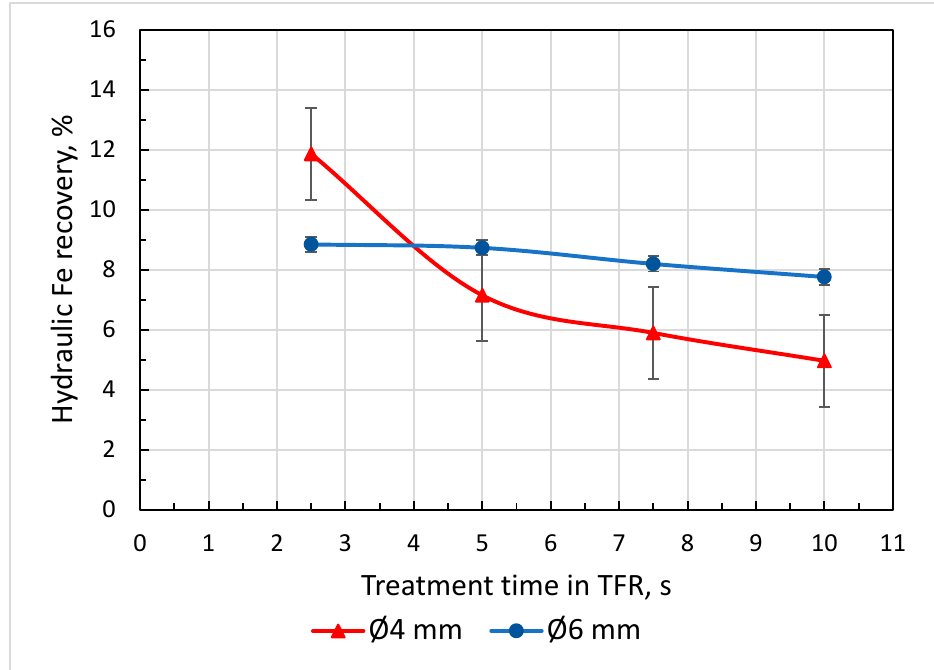
Figure 10. Dependence of the share of the hydraulic entrainment of iron in tailings (froth product) on the treatment time in TFRs having 4 and 6 mm inner diameters. CTAB dosage—20 g/t, fine bubbles dosage—0.21 mL/g.